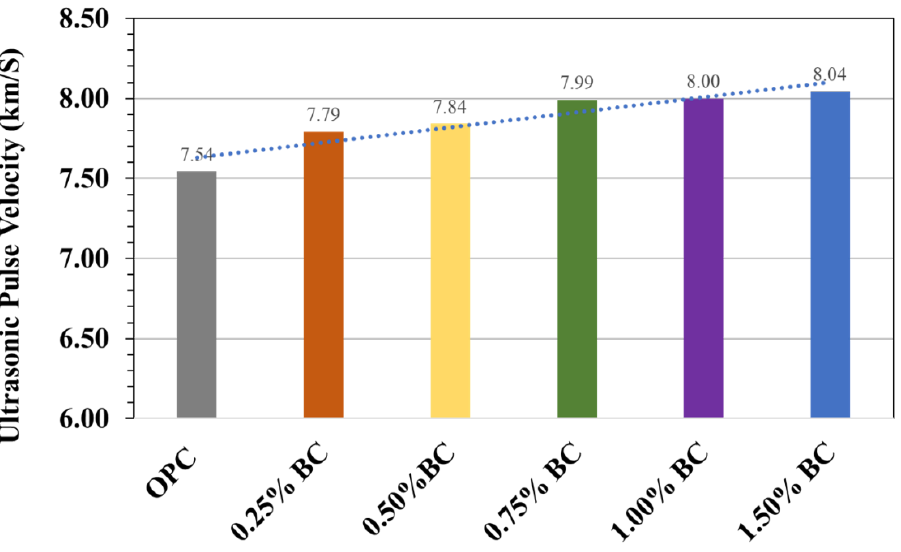
Figure 8. Ultrasonic pulse velocity for various concrete specimens.